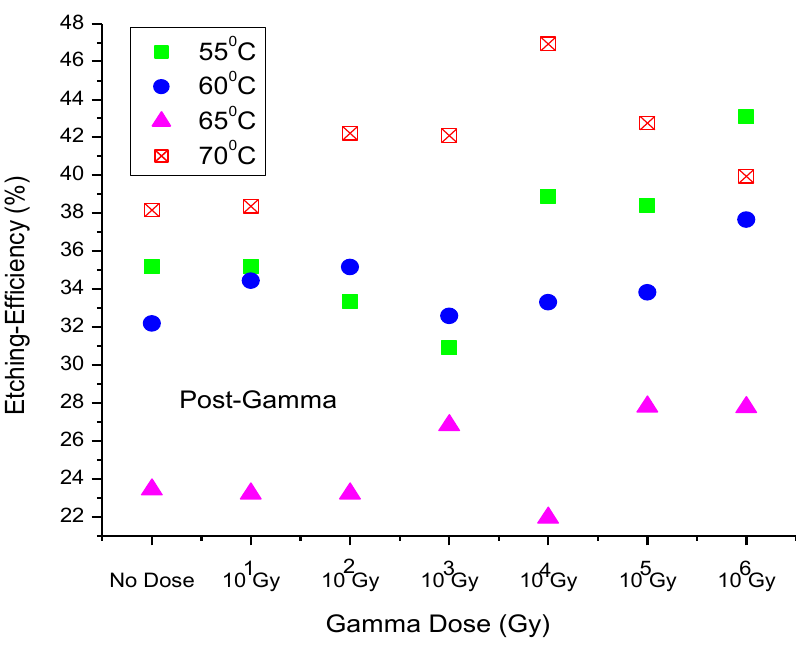
Figure 2. Plot of gamma dose vs. critical etching efficiency for post -gamma radiation exposed PADC (American Acrylics) detectors at different etching